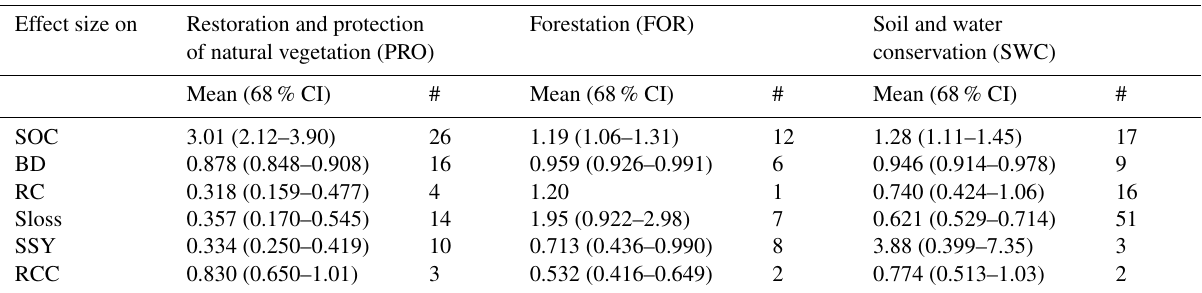
Figure 5. Response ratio of natural infrastructure interventions (PRO, FOR, SWC) relative to cropland and rangeland. The plots show the mean response ratio (points) and its standard error (solid lines) for soil organic carbon (SOC) and bulk density (BD) in the topsoil, runoff coefficient (RC) and soil loss rate (Sloss), specific sediment yield (SSY) and catchment-wide runoff ratio (RCC). When the number of individual treatment-control studies is below 4, the symbols are shown in lighter colors. Table 2. Summary of response ratios, showing the effect of restoration and protection of natural vegetation (PRO), forestation (FOR), and soil and water conservation (SWC) on soil quality and erosion. The mean value and the 68% confidence interval (CI) are given, as well as the number of treatment-control studies